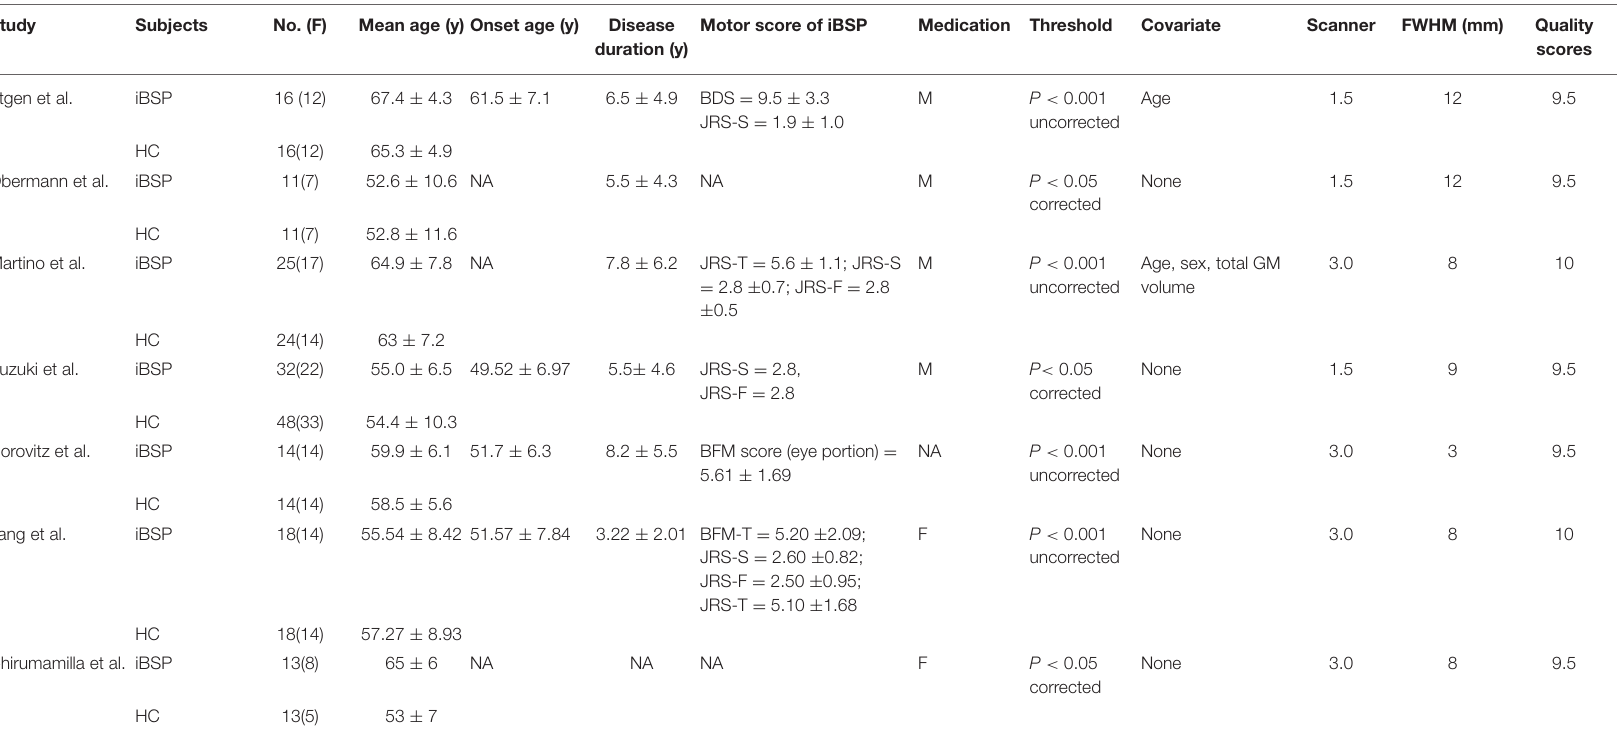
TABLE 1 | Characteristics of included VBM studies in the